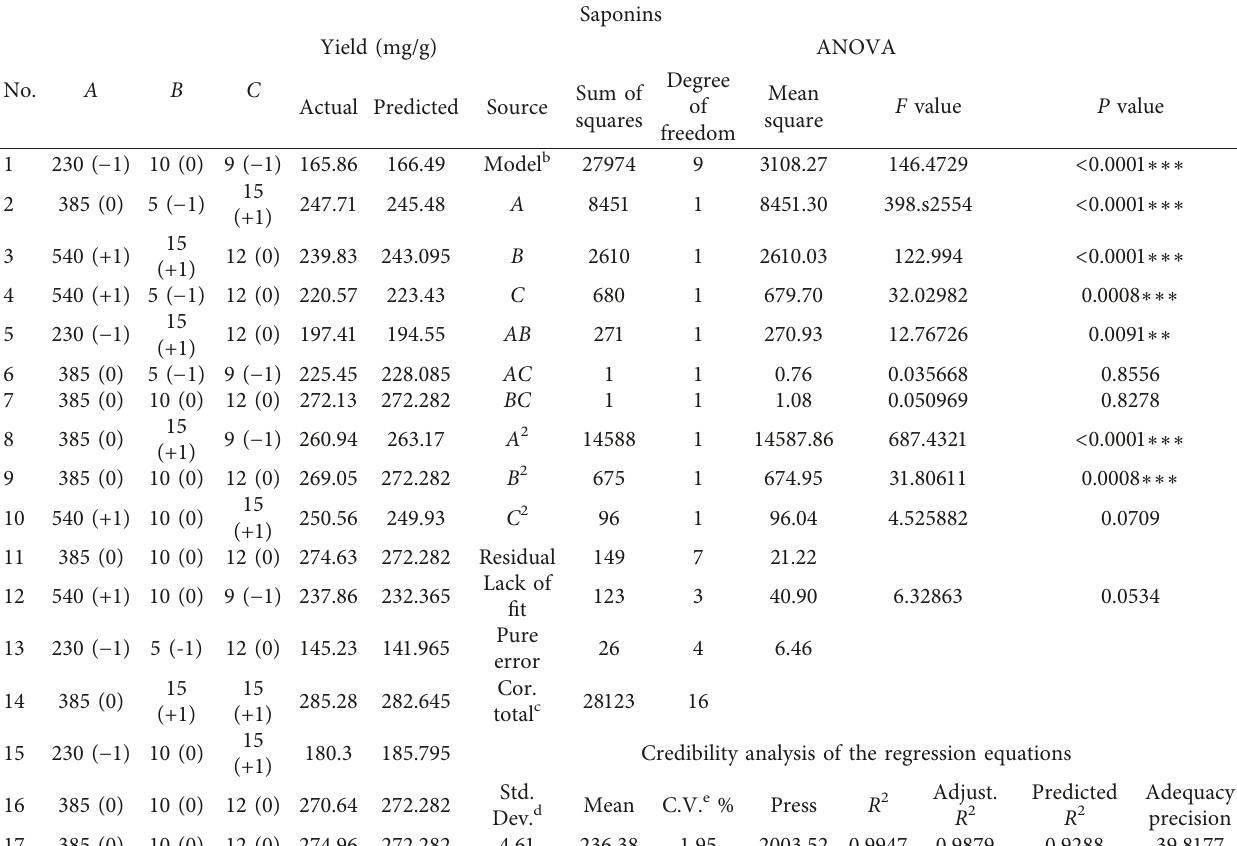
Table 2: Experimental design matrix for the Box–Behnken design to screen for variables that determine the yield of saponins and the ANOVA results.